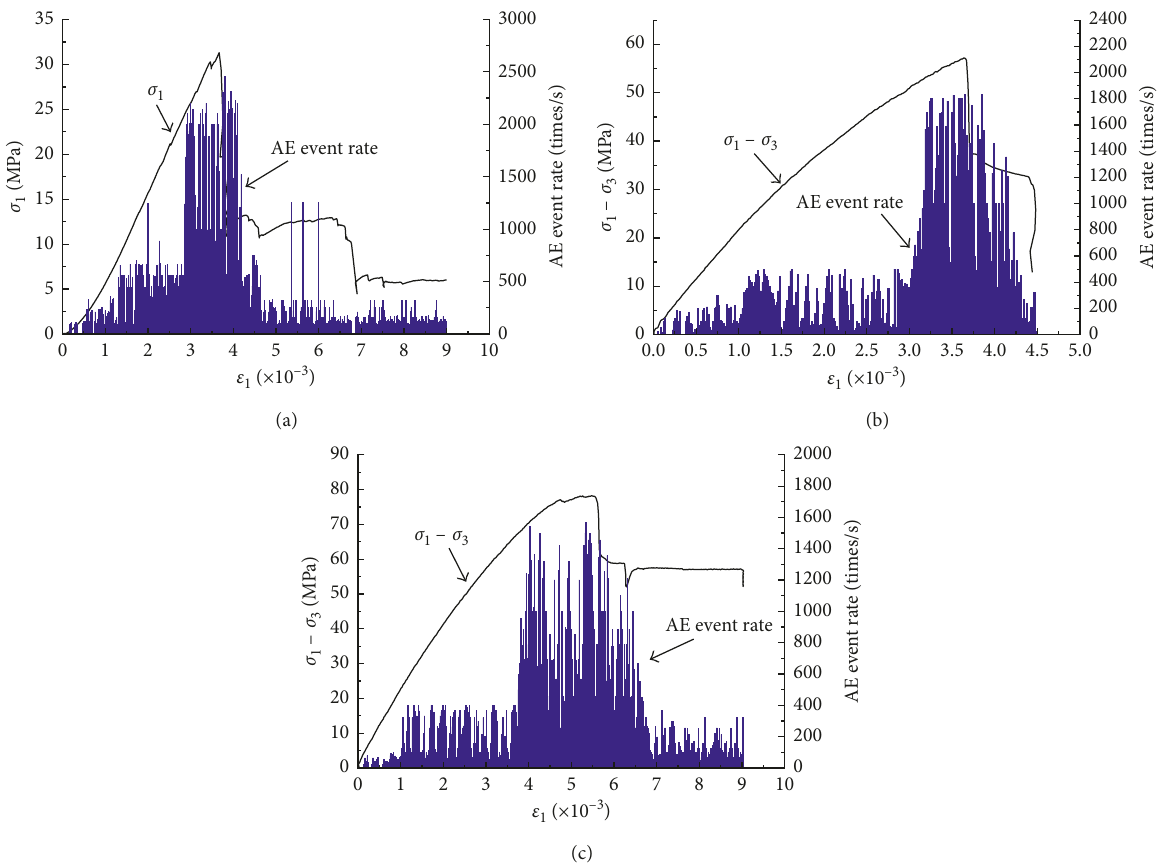
Figure 11: Variation curves of AE event rates for dry samples under different confining pressures. (a) 0 MPa. (b) 15MPa. (c) 30MPa.